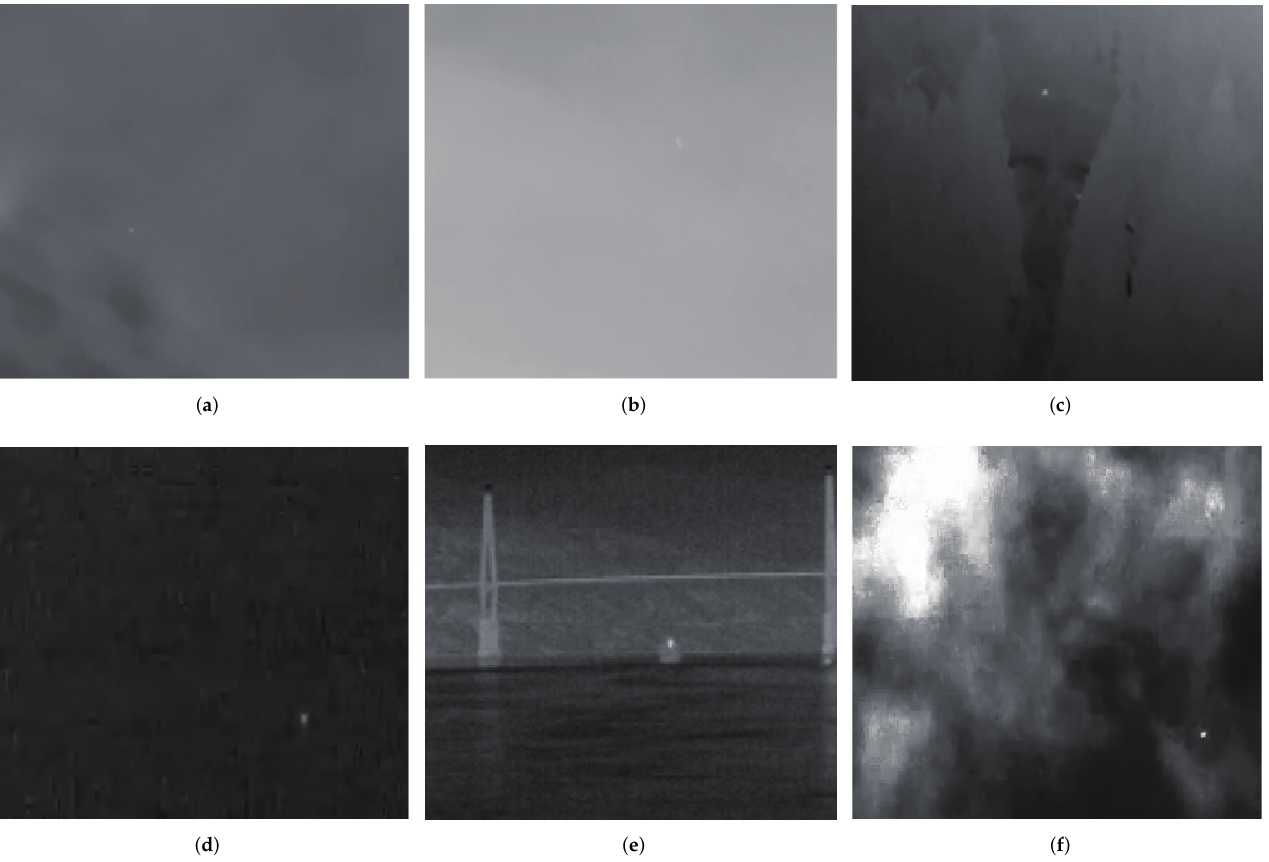
Figure 6. Infrared images of some real scenes. ( a ) Scene 1 (Seq1). ( b ) Scene 2 (Seq2). ( c ) Scene 3 (Seq3).